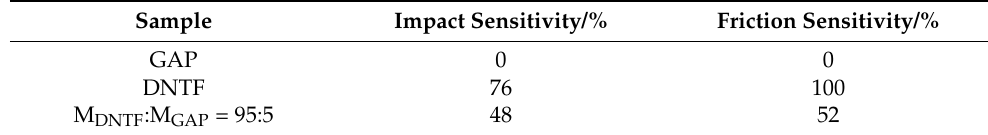
Table 2. Impact and friction sensitivity test results.